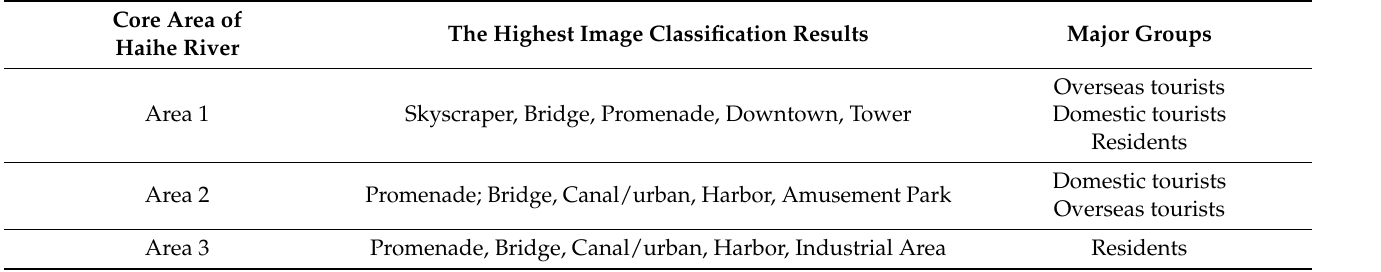
Table 3. Core area of the Haihe River based on visualization results.